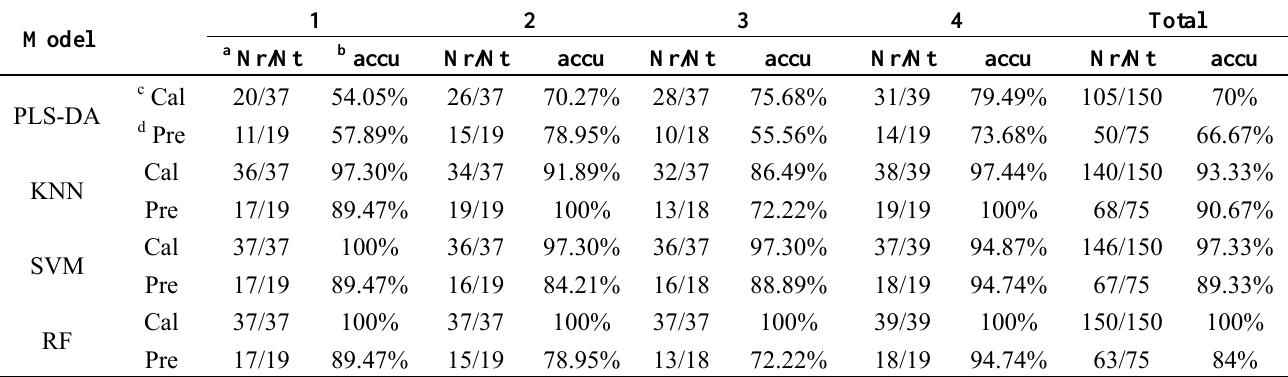
Table 2. Results of classification models based on optimal